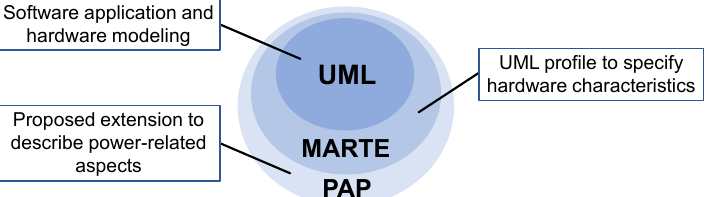
Figure 6. Relation between the unified modeling language (UML), the standard modeling and analysis of real-time and embedded systems (MARTE), and the Power Analysis Profile